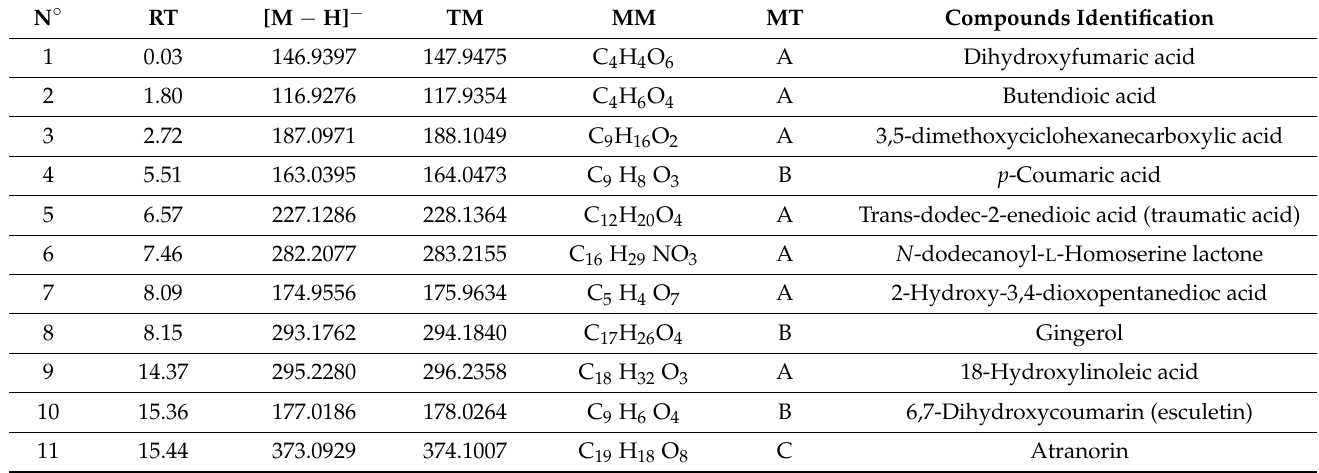
Table 2. Identification of metabolites in WA-hex of Physcia mediterranea by UHPLC/ESI/MS/MS. N